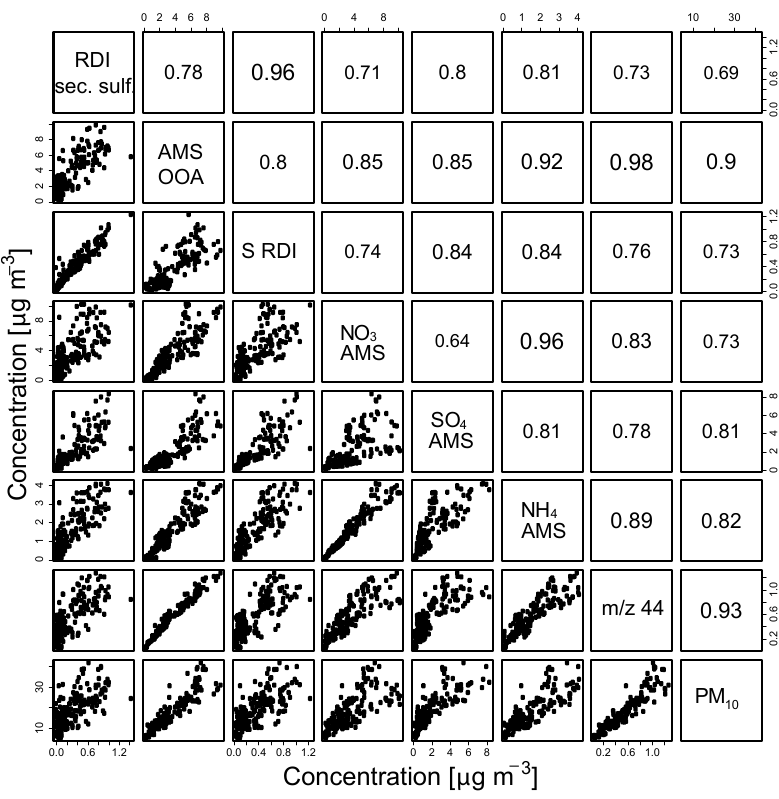
Fig. 10. Matrix of scatter plots showing the pair-wise correlations of the secondary sulfate factor found for PM 1 − 0 . 1 with RDI-PMF, AMS- OOA factor, S measured with RDI, NO − , SO 2 − , NH + , m/z 44 measured with AMS and total PM 10 mass concentrations (shown are only 3 4 4 most relevant species, the ones not shown do not have significant correlation). The panels in the upper right half show the Pearson correlation coefficients and the lower left panels show corresponding data